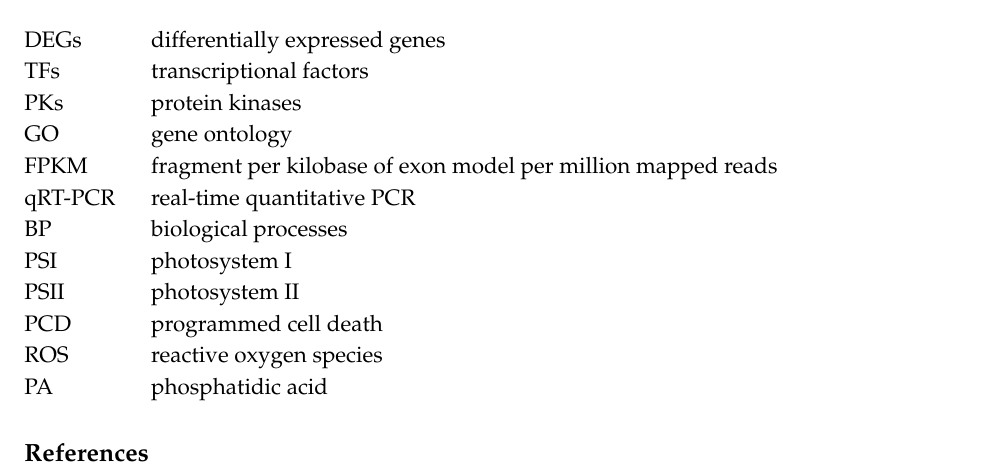
Figure S1: The assembled transcriptome information of C. reinhardtii , Figure S2: The FPKM density distribution of C. reinhardtii , Table S1: Unigenes of C. reinhardtii annotated in A. thaliana genome by BLASTX analysis, Table S2: Information of the 5920 up- and 4715 down-regulated unigenes in C. reinhardtii , Table S3: The Gene Ontology (GO) enrichment results of the dys-regulated genes in C. reinhardtii , Table S4: The MapMan pathways enrichment results of the dys-regulated genes in C. reinhardtii , Table S5: Information of the differently expressed transcription factors (TFs) and protein kinases (PKs), Table S6: Information of the qRT–PCR primers. Author Contributions: L.Z. and N.W. conceived and designed the study. L.Z., N.W., Z.Q., M.L., X.Z. performed the data collection and analysis. L.Z. and N.W. wrote the paper. L.Z., S.F. and X.Z. reviewed and edited